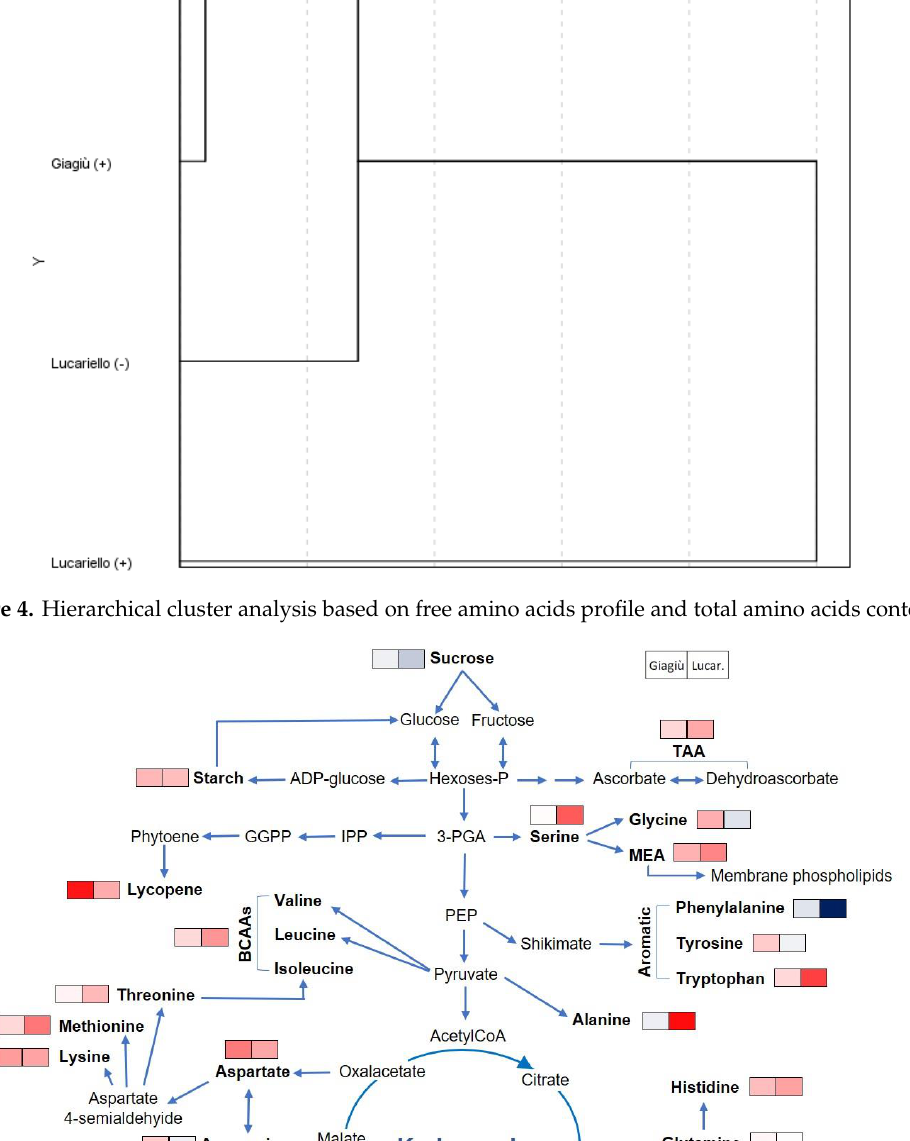
Figure 6. Hierarchical cluster analysis based on total yield, number of fruits, fruit mean weight, total soluble solids (TSS) content, dry matter, lipophilic and hydrophilic (LAA and HAA), starch, lycopene, sucrose, macro (phosphorus, potassium, calcium and magnesium) and micro (sodium, iron, copper, manganese and zinc) mineral content and total amino acids content.